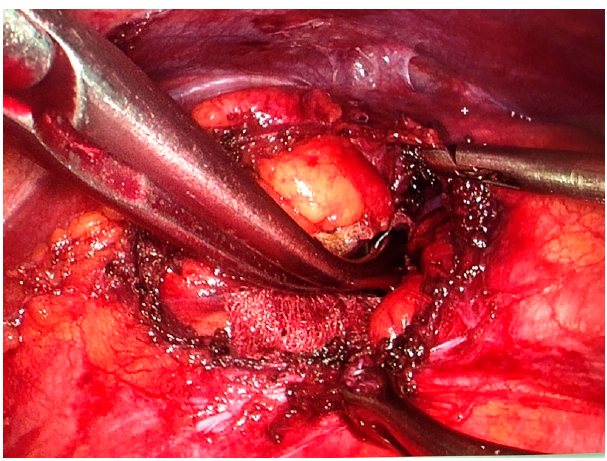
Surgeries 2021 , 2 , FOR PEER REVIEW Figure 3. Diaphragmatic breach, with hernial sac dissected and pushed back in the abdominal cavity.